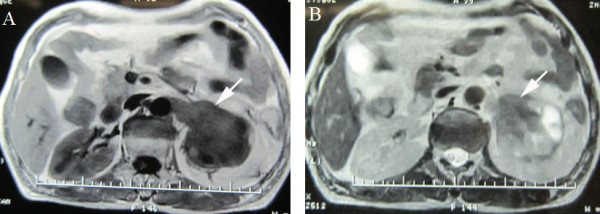
MRI showing the left renal tumor. The mass in the left renal sinus showed homogeneous isointensity on T1WI (A, arrow) and hypointensity on T2WI (B, arrow).